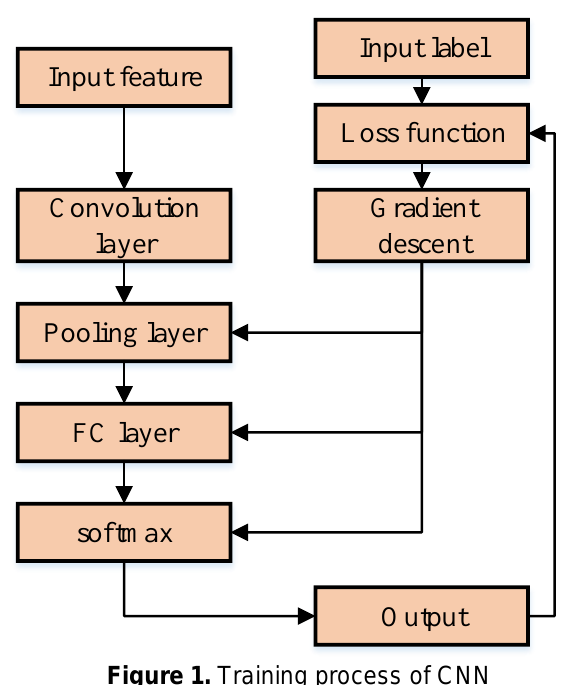
Figure 1. Training process of